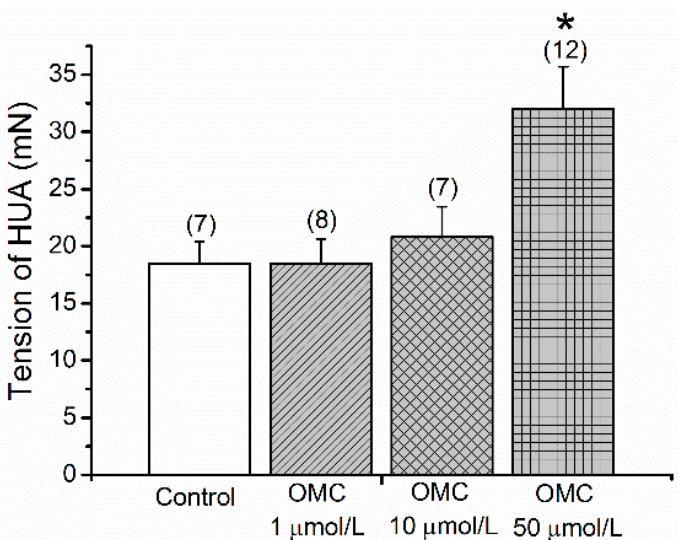
Figure 1. Tension induced by serotonin (5-HT, 1 µ mol/L) after exposure to cumulative concentrations of octylmethoxycinnamate (OMC; 0.001–50 µ mol/L) on the human umbilical artery (HUA)-rings incubated with OMC. Data are presented as mean (bars) ± standard error of mean (S.E.M.) of the number n within brackets. * Represents a significant difference against HUA control ( p < 0.05, one-way ANOVA with